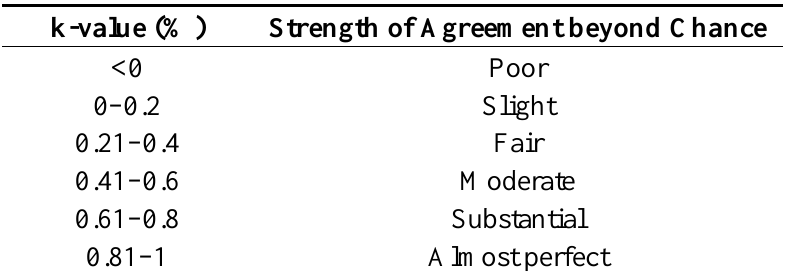
Table 1. Kappa statistics interpretation